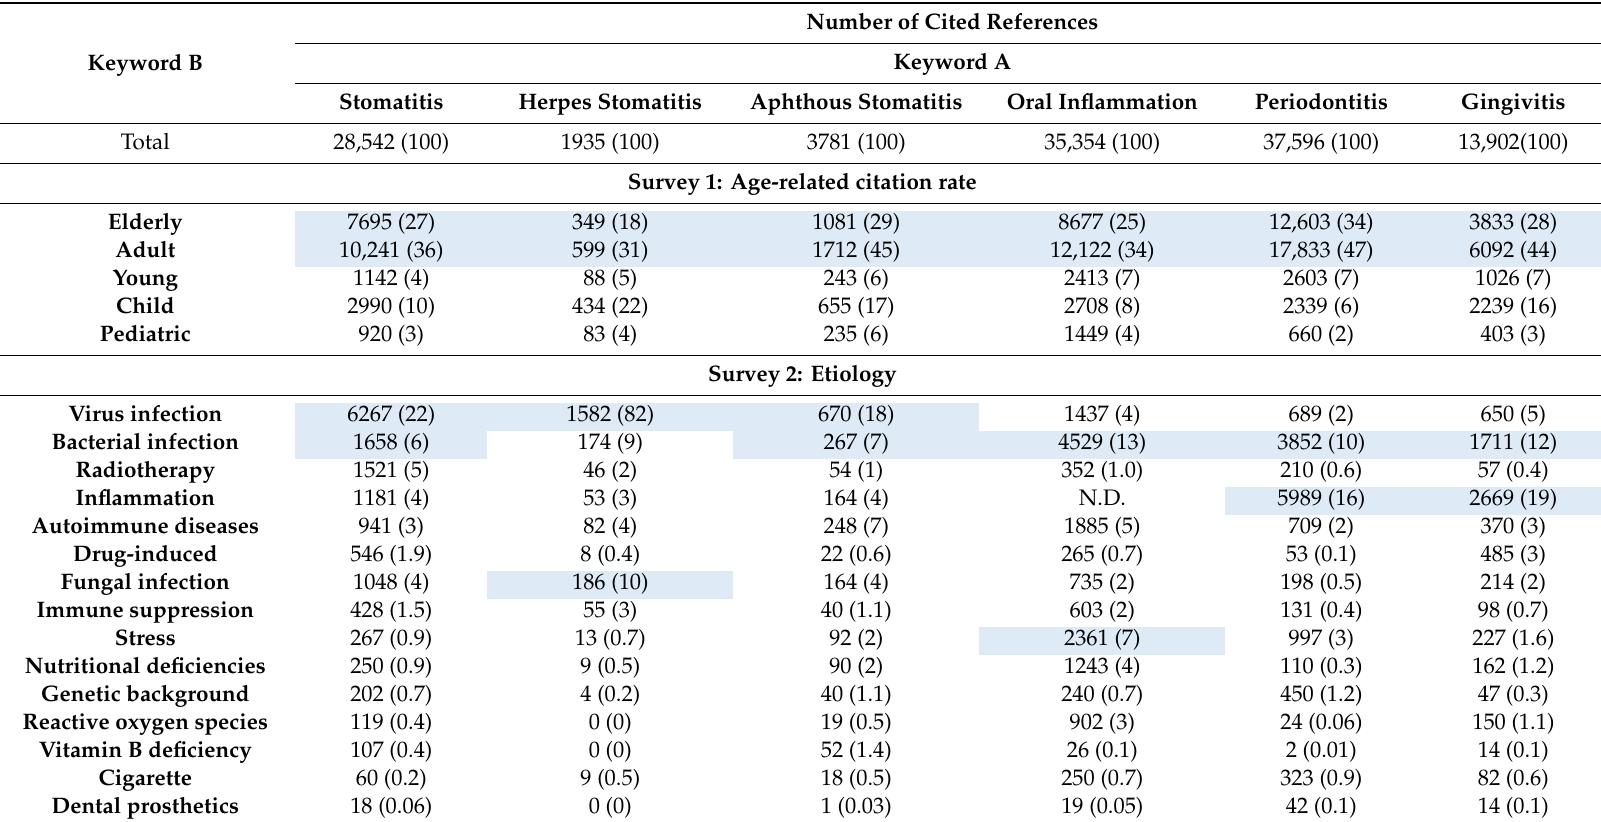
Table 1. Survey of publications of stomatitis and related oral inflammations, narrowed down by age-di ff erence, etiology and treatment (based on PubMed search, 13 April